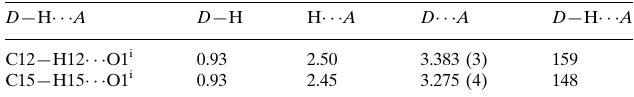
Hydrogen-bond geometry (A˚ , (cid:1)